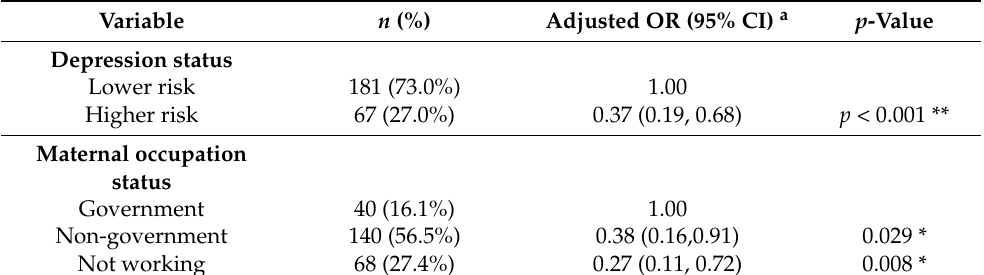
Table 5. Factors associated with positive breastfeeding attitude from stepwise logistic regression analysis ( n =